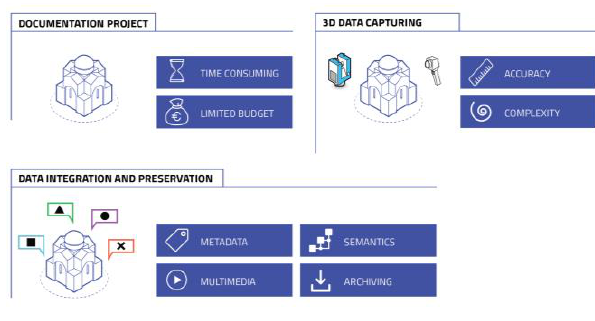
Figure 2. Main challenges in 3D documentation